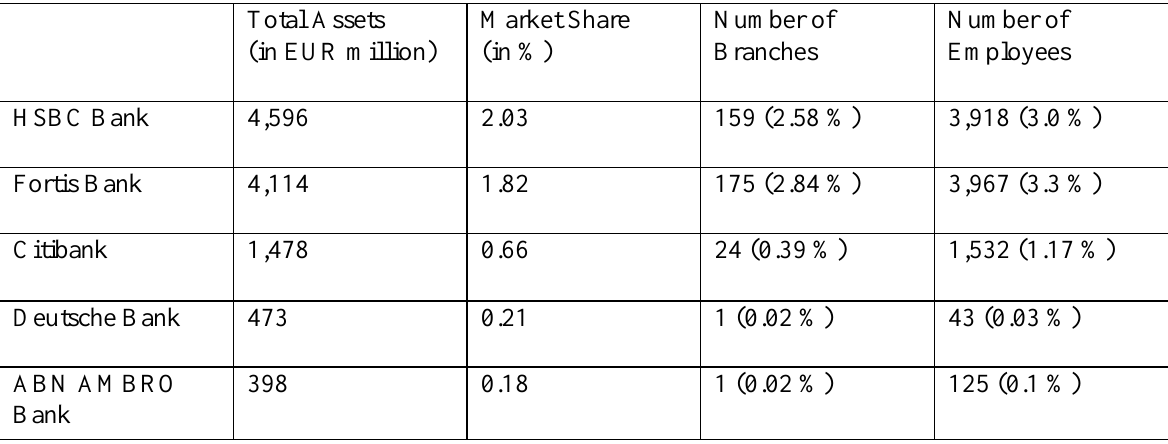
Table 3a. Five Largest Foreign Banks (in terms of Assets) as of Sept. 30,